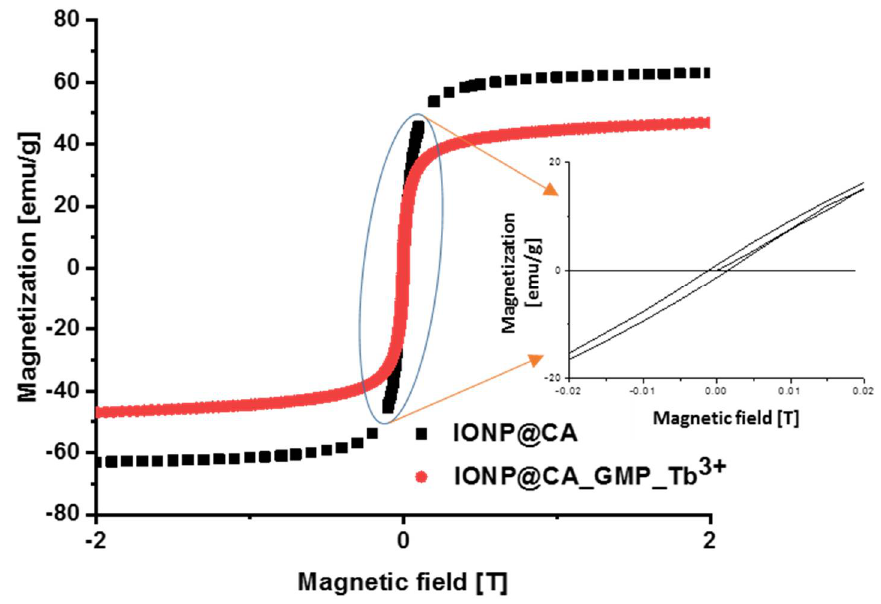
Figure 5. Magnetization measurement for IONPs@CA and IONPs@CA_GMP_Tb 3+ . The inset shows the expansion of the magnetization loop in the range +/ − 0.02 T to show the remanence and coercivity of the synthesized nanoparticles.